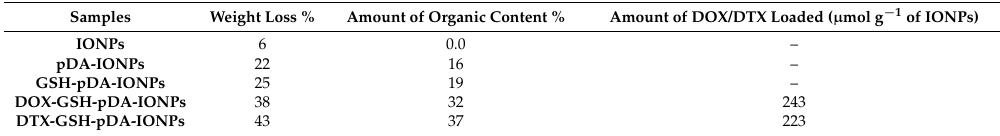
Figure 8. Thermogravimetric analysis (TGA) curves showing the sequential grafting of different organic molecules on the surface of IONPs. Table 2. Detailed analysis of the weight loss of synthesized nanoparticles and quantification of the grafted molecules.